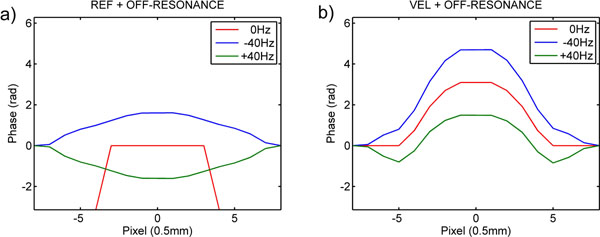
The phase across a small vessel with no flow is ideally flat with infinitely steep sides (a-red); off-resonance causes a distortion of the flat phase such that it becomes curved (simulated off-resonance) (a-blue/green) and can be seen in the LOW flow phase images in Figure 2 where both Ref ph and Vel ph are similar. Velocity mapping induces phase relative to velocity within a pixel, the ideal Ref. phase over the vessel with laminar flow remains flat (a-red) and for Vel. phase has parabolic profile (b-red). When the Vel. image is acquired with off-resonance, the phase from these 2 effects can add constructively or destructively resulting in distortion of the velocity profile (Figure 1-PEAK VM). Signal loss in edge pixels with high velocity shear can be increased (b-blue) or decreased (b-green) depending on the direction of the off-resonance phase resulting in the implosion (Figure 1-I) and explosion (Figure 1-E) artefacts in Vel. mg images.